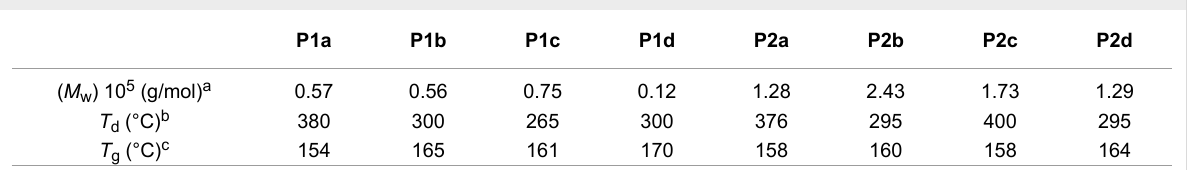
Table 1: Thermal data and molecular weights for polymers P1 and P2 .